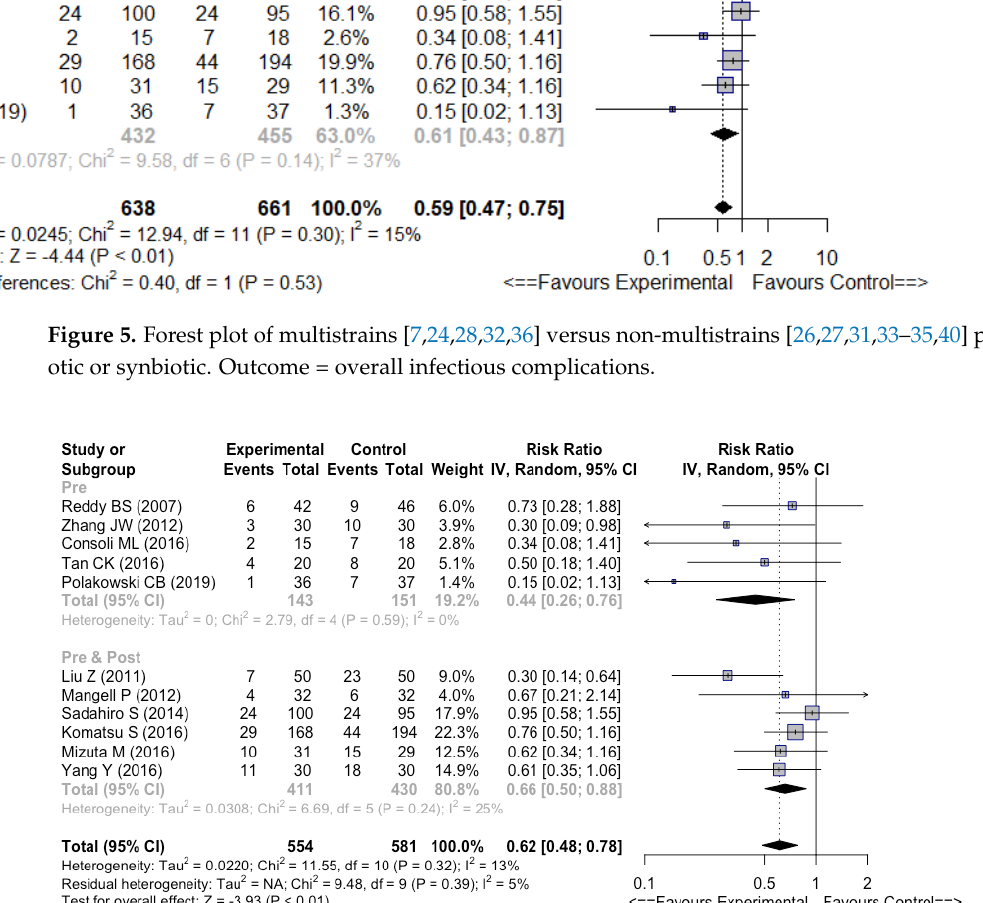
Figure 5. Forest plot of multistrains [7,24,28,32,36] versus non-multistrains [26,27,31,33 – 35,40] pro- biotic or synbiotic. Outcome = overall infectious complications.